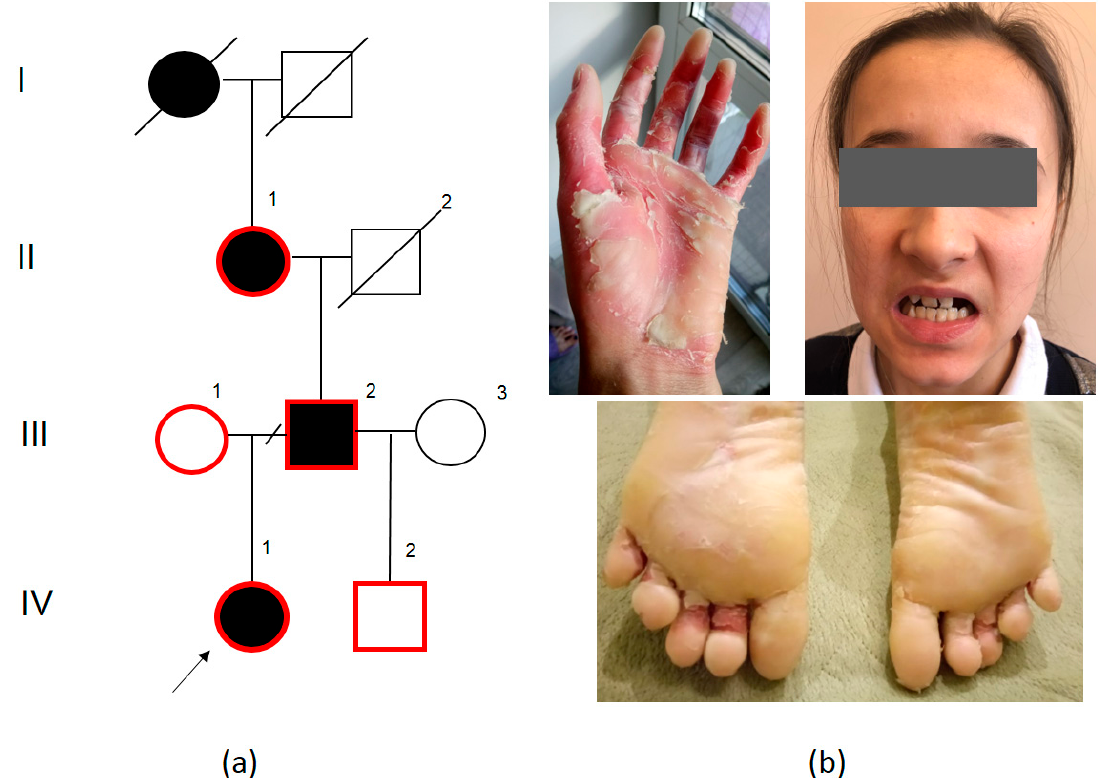
Figure 2. PPK2 pedigree: black—affected family members, white—healthy family members, I–IV—generations, 1–3—number of the person in the generation, red contour—examined and geno- typed family members ( a ); symptoms of PPK in patients: diffuse palmoplantar keratoderma, keratol- ysis, perioral keratosis, fissures in the corners of the mouth, hypodontia ( b